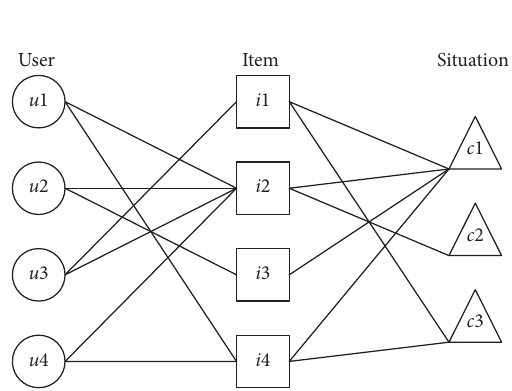
Figure 2: Tripartite graph